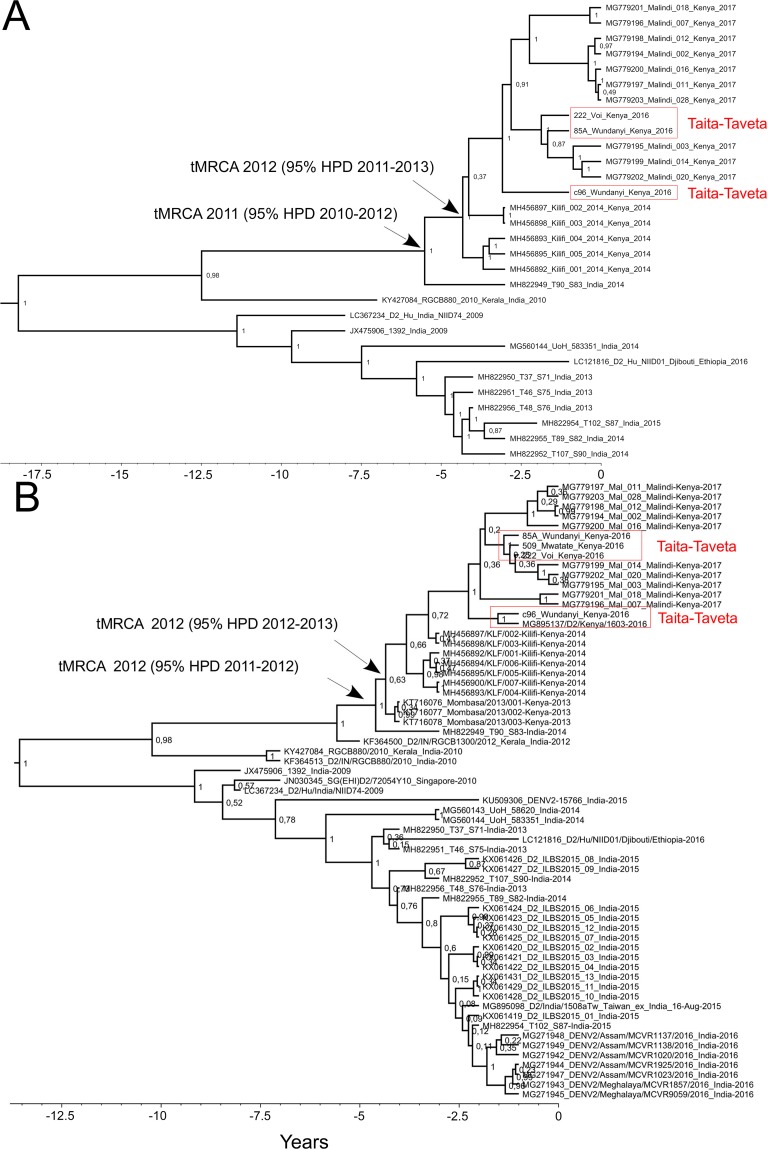
Phylogenetic trees of dengue virus 2 a) Complete open reading frame sequences and b) envelope gene sequences. In a) the nodes of respective tMRCAs are shown with arrows. For both a) and b), maximum clade credibility tree of dengue virus 2 are presented, including strains that had >98% sequence identity in the BLAST search. Trees were constructed using the Bayesian MCMC method with the TN93 model of substitution with a 4-category gamma-distributed variation among sites and a proportion of invariable sites, log-normal relaxed clock model and exponential growth demographic model. Posterior probabilities are shown for each node.